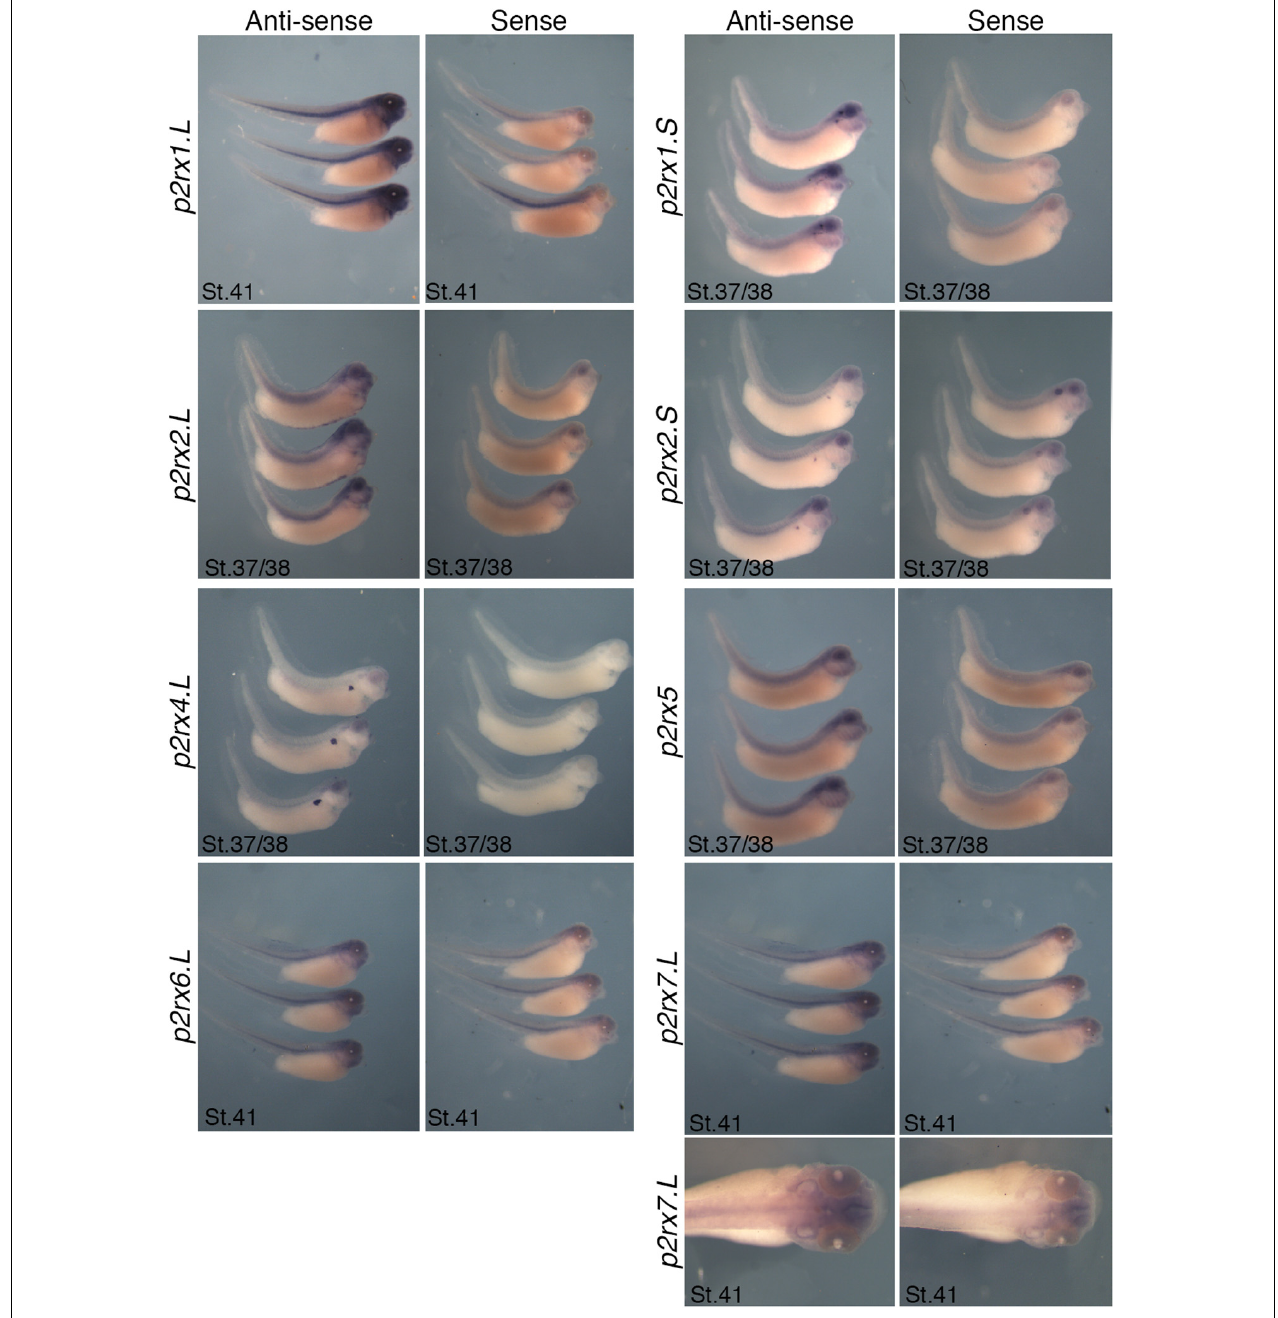
FIGURE 4 | Comparative staining obtained with the antisense and sense probes of p2rx genes. Lateral views of three representative embryos at stage 37/38 or stage 41stained with the antisense and sense probes for p2rx1.L, p2rx1.S, p2rx2.L, p2rx2.S, p2rx4.L, p2rx6.L, and p2rx7.L . subunits and p2rx5 homeologs. Some unspecific staining, due to probe trapping, can be observed in the head region (brain ventricles, otic vesicle) and in the notochord. For p2r7.L subunit, a dorsal view of a representative embryo completes the lateral views. For lateral views, dorsal is up and anterior is right. For dorsal views, anterior is up.